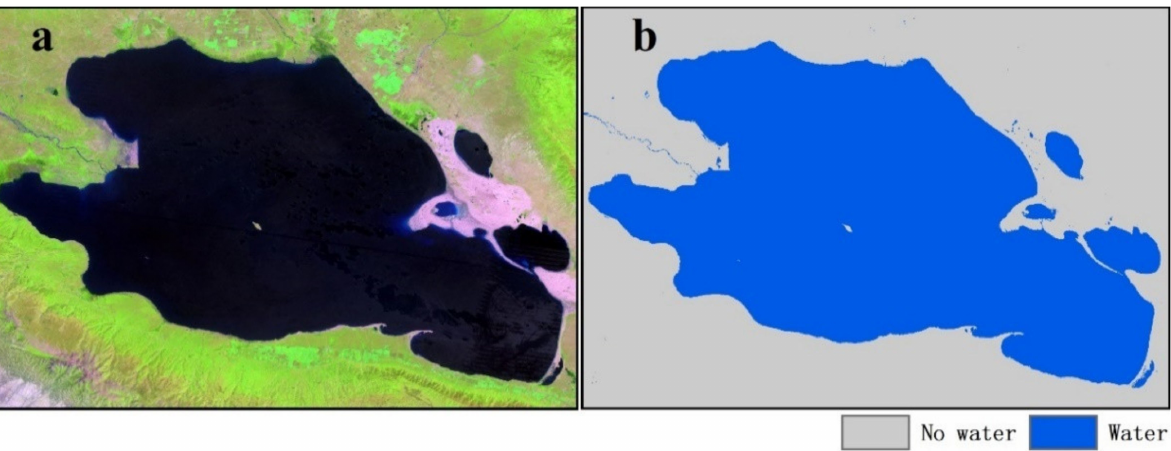
Figure 4. Illustration of water extraction for Qinghai Lake in July 2010. ( a ) is the original image; ( b ) is the preliminary result of extracting the water body using